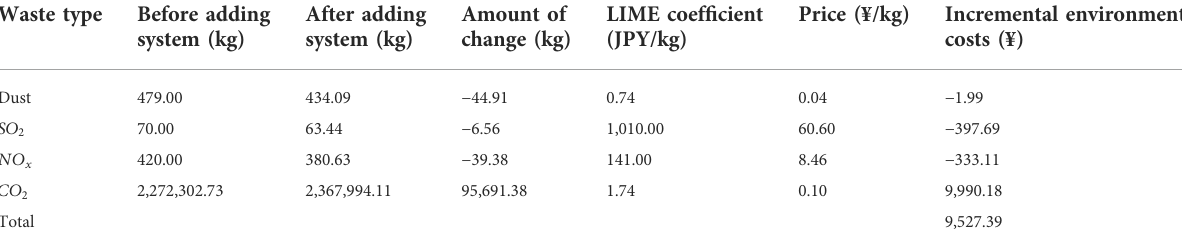
TABLE 12 Incremental emissions and environmental costs after adding the system. Waste